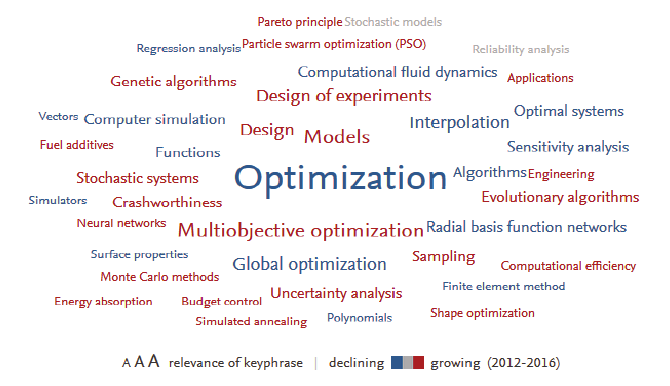
Fig. 3. The top 50 key-phrases by relevance in the past five years papers (656